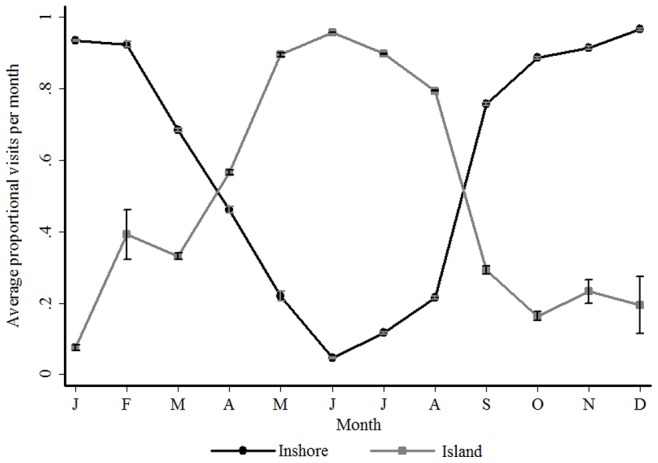
The proportion of visits to each region in the Bay for all years combined.Average (± s. d.) proportion of visits to the Inshore (black line) and Island (gray line) areas of False Bay for each month of the year.